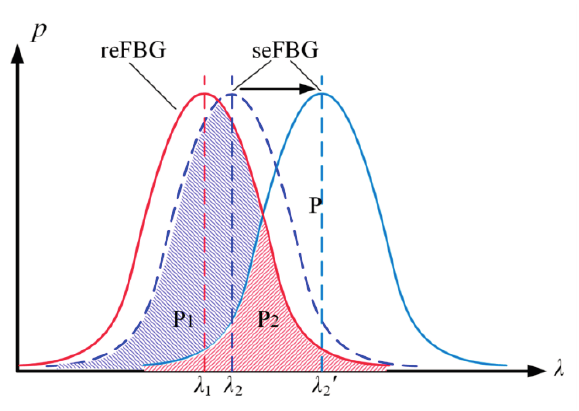
Figure 2. Principle of the proposed FBG interrogation method: P is the reflection P P + is the initial overlapping reflection spectrum power of spectrum power of seFBG; 1 2 P is the overlapping reflection spectrum power of the seFBG the seFBG and the reFBG; 2 and the reFBG after the influence of the external physical